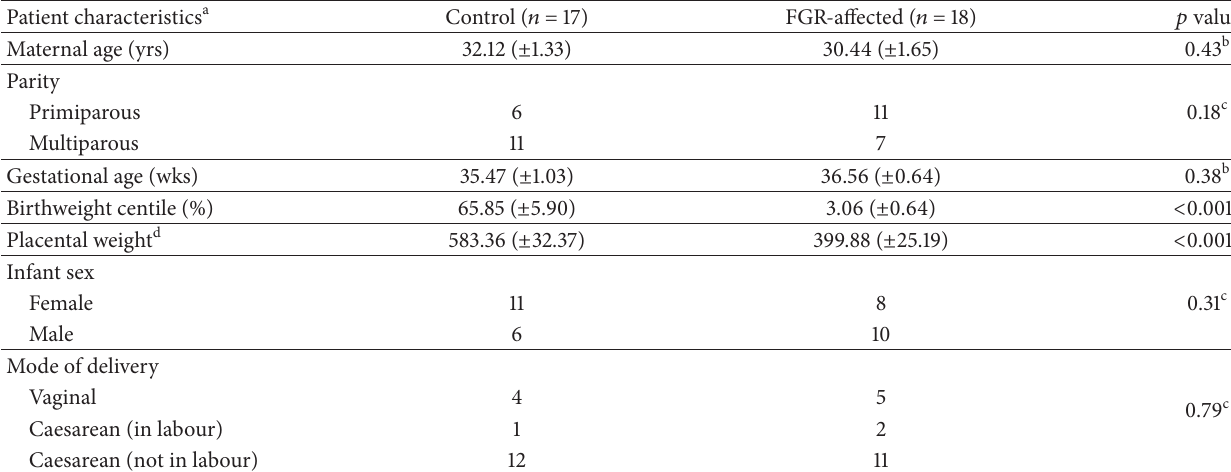
Table 2: Patient demographic and obstetric characteristics.